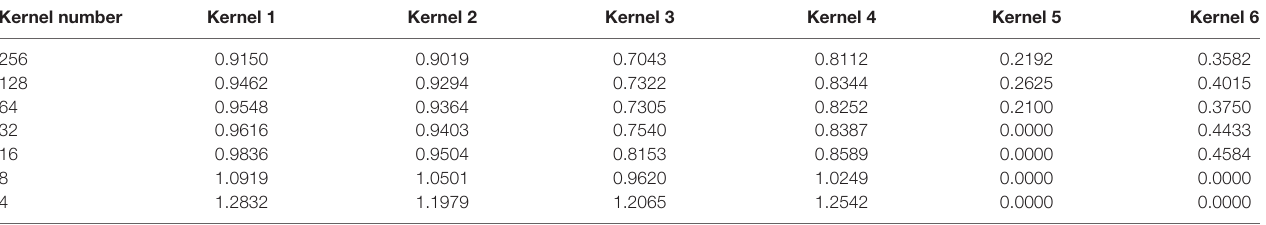
TABLE 3 | Absolute value of weights of several kernels during different pruning stages in the dense layer.